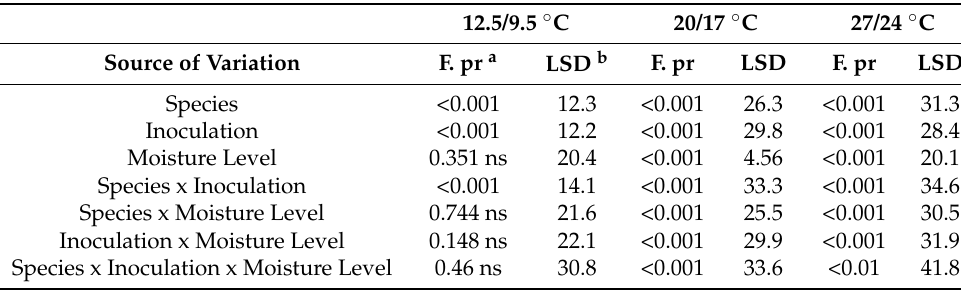
Table 2. Statistical main effects and interactions ( p -value and LSD) from mean percentage coumestrol production in two species of annual Medicago spp. inoculated with Phoma medicaginis at three different temperatures and two different moisture